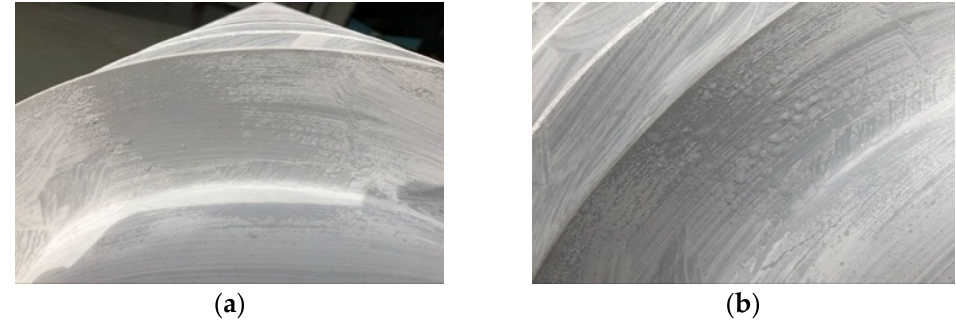
Figure 4. Hydrophobicity state of the sample surface: ( a ) HC7; ( b ) HC5~6.